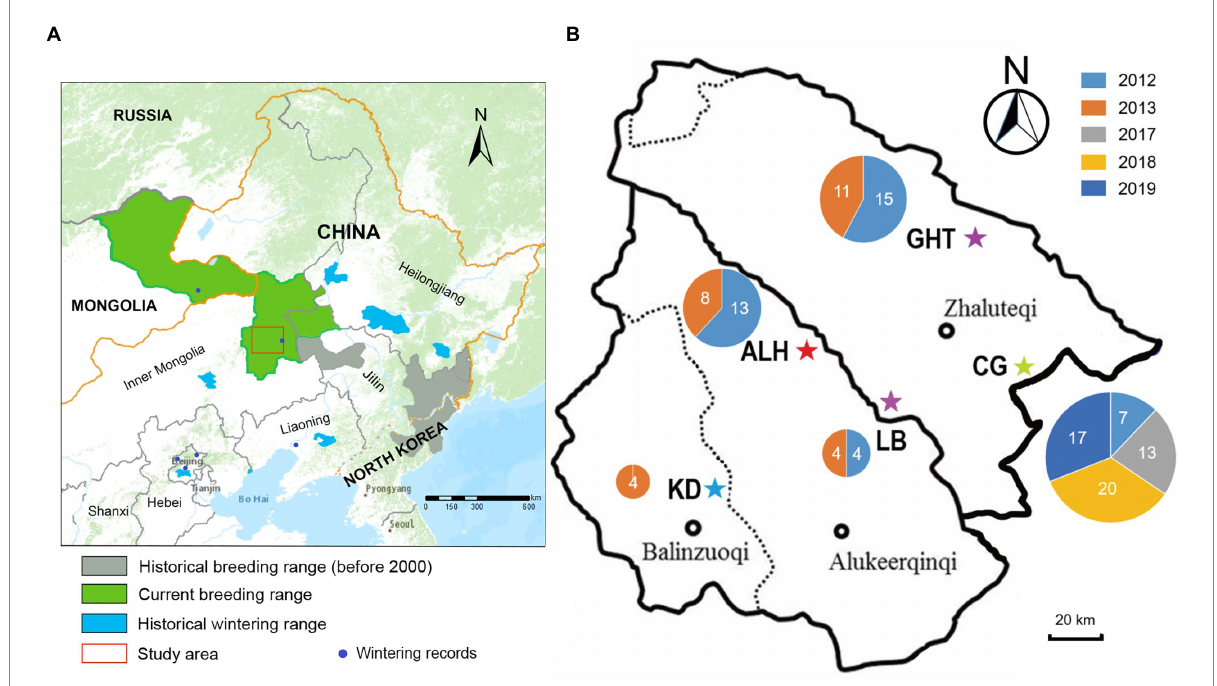
FIGURE 1 Distribution range and sampling information of Jankowski’s Bunting. (A) Approximate breeding distribution of Jankowski’s Bunting and location of the sampling region. Information on distribution ranges was derived from previous studies (Han et al., 2017, 2021). (B) Detailed location of sampling sites. Pentagrams indicate sampling sites. The size of the circle is proportional to the sample size at each site, and the number indicates the sample size in different years (see color legend). ALH, Aolunhua; CG, Chagantaoligao; GHT, Gahaitu; KD, Kundu; LB,